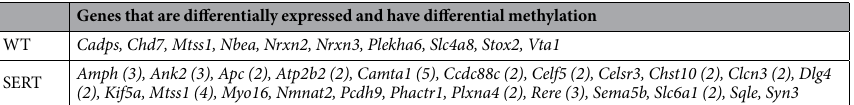
Table 2. Integration of DEGs and DMRs datasets from embryos in WT or SERT dams in response to prenatal stress identifies genes that are differentially expressed and have differential methylation. I. Parenthesis indicate the number of DMRs found within and/or surrounding each gene. II. List reflects genes that are: listed in SFARI and/or AutismKB databases, differentially expressed (fold change ≥ 1.5 or ≤− 1.5, p ≤ 0.05) and differentially methylated (p ≤ 0.05) in the WT or SERT embryos in response to prenatal